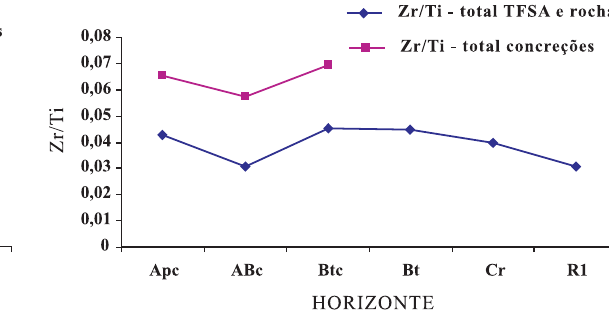
O . Figura 4. Relação 2 3